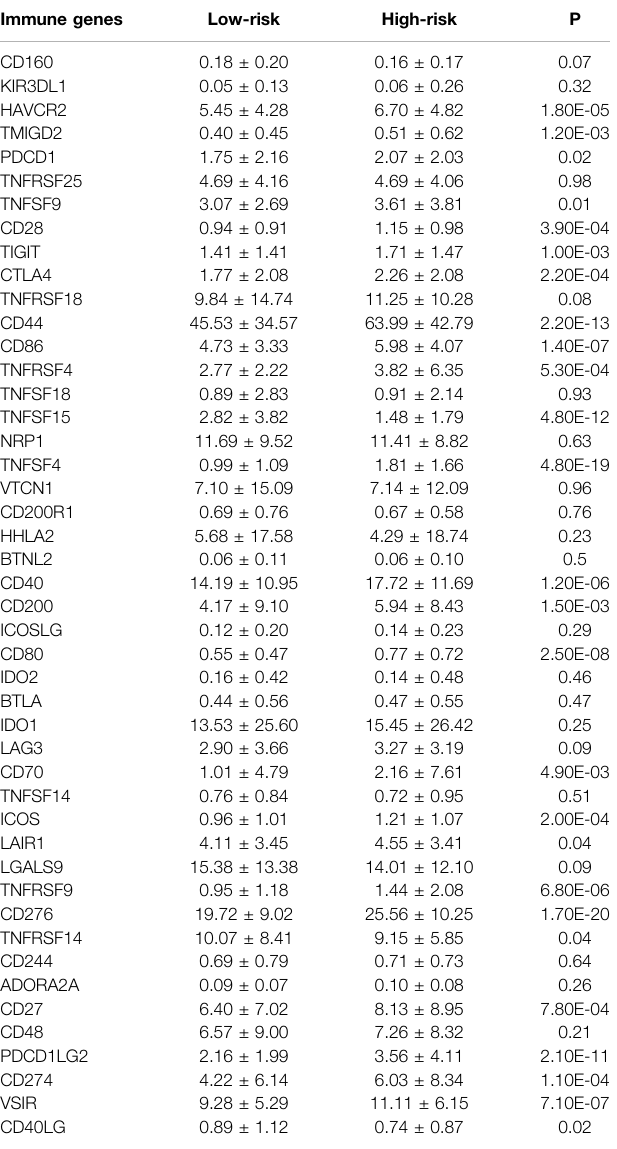
TABLE 5 | The expression levels of NSCLC immune cell markers in the high- and low-risk groups. Immune genes Low-risk High-risk